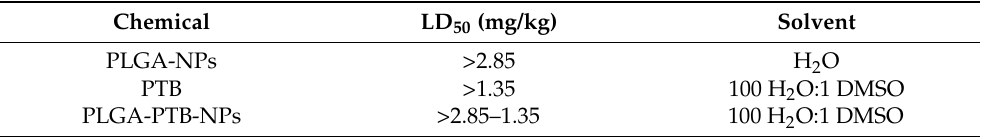
Table 1. Survival of G. mellonella larvae following administration of PLGA-NPs, PTB, and PLGA-PTB- NPs by intra-hemocoel injection. Every experiment was conducted with 10 larvae for each group in triplicate. All values are the mean of three independent